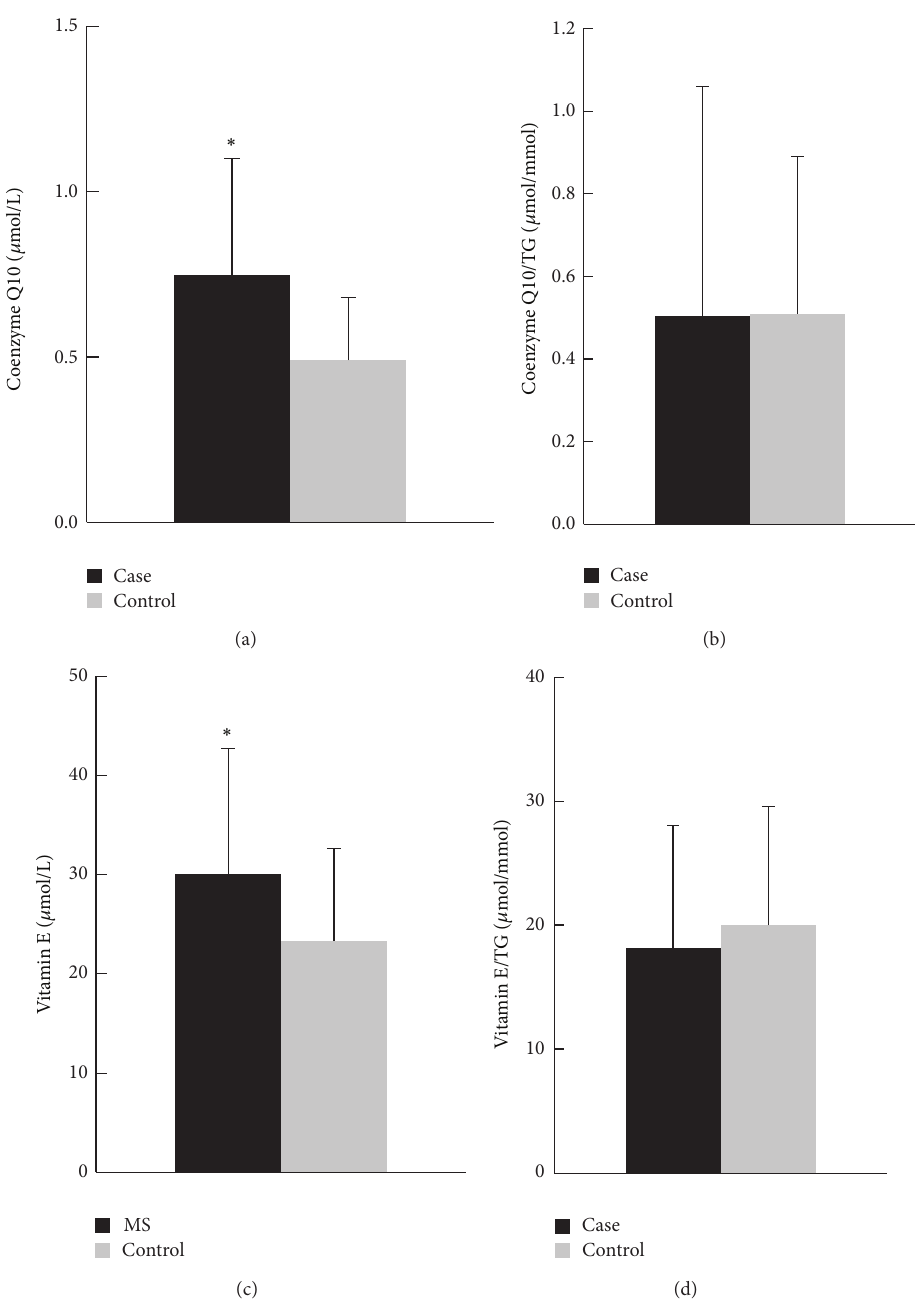
Figure 1: The levels of plasma coenzyme Q10 and vitamin E. ∗ Values were significantly different between case and control groups; 𝑃 < 0.01 . TG: